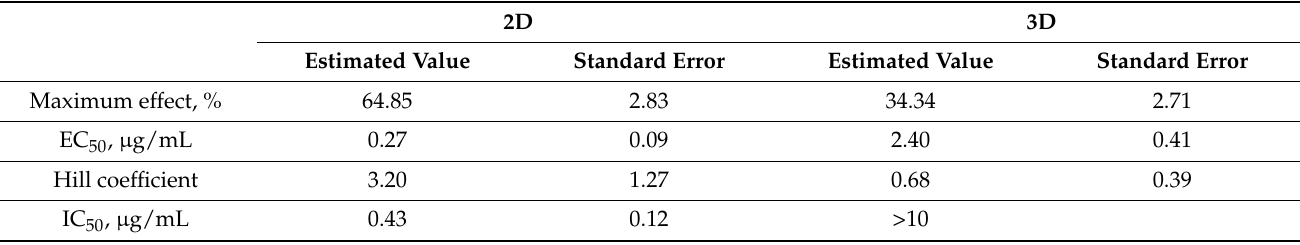
Table A6. The results of fitting a dose–response model to the measurements of cell viability. Estimated values of the dose–response model parameters for free Dox in 2D and 3D.